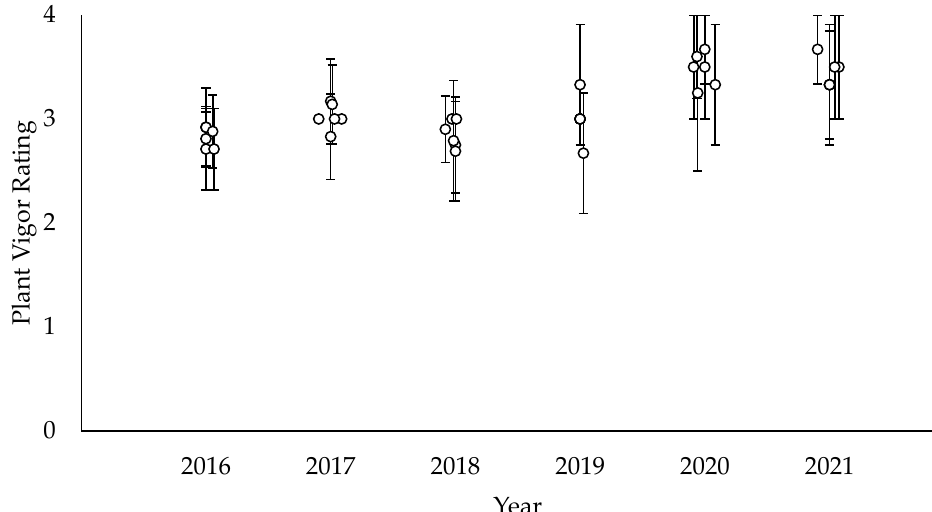
Figure 6. Average plant vigor ratings for all species assessed in the shallow cells at the KTW from 2016 to 2021.